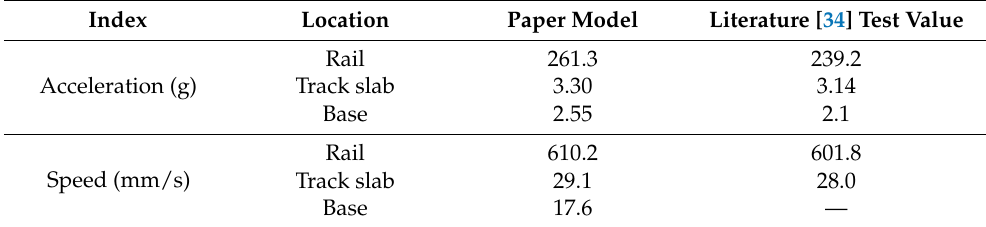
Table 2. Dynamic response of each structural layer under the action of axle